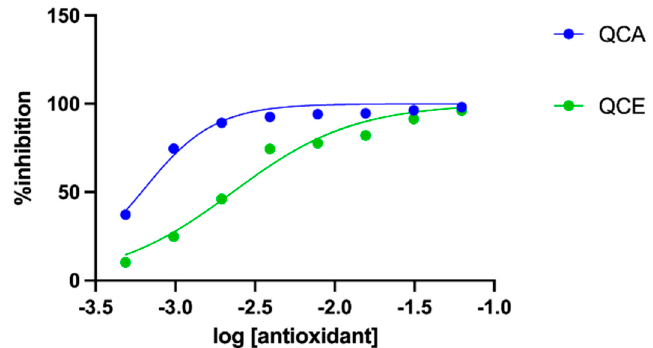
Figure 4. Logarithmic curves of antioxidant activity of QC extracts (n = 3).